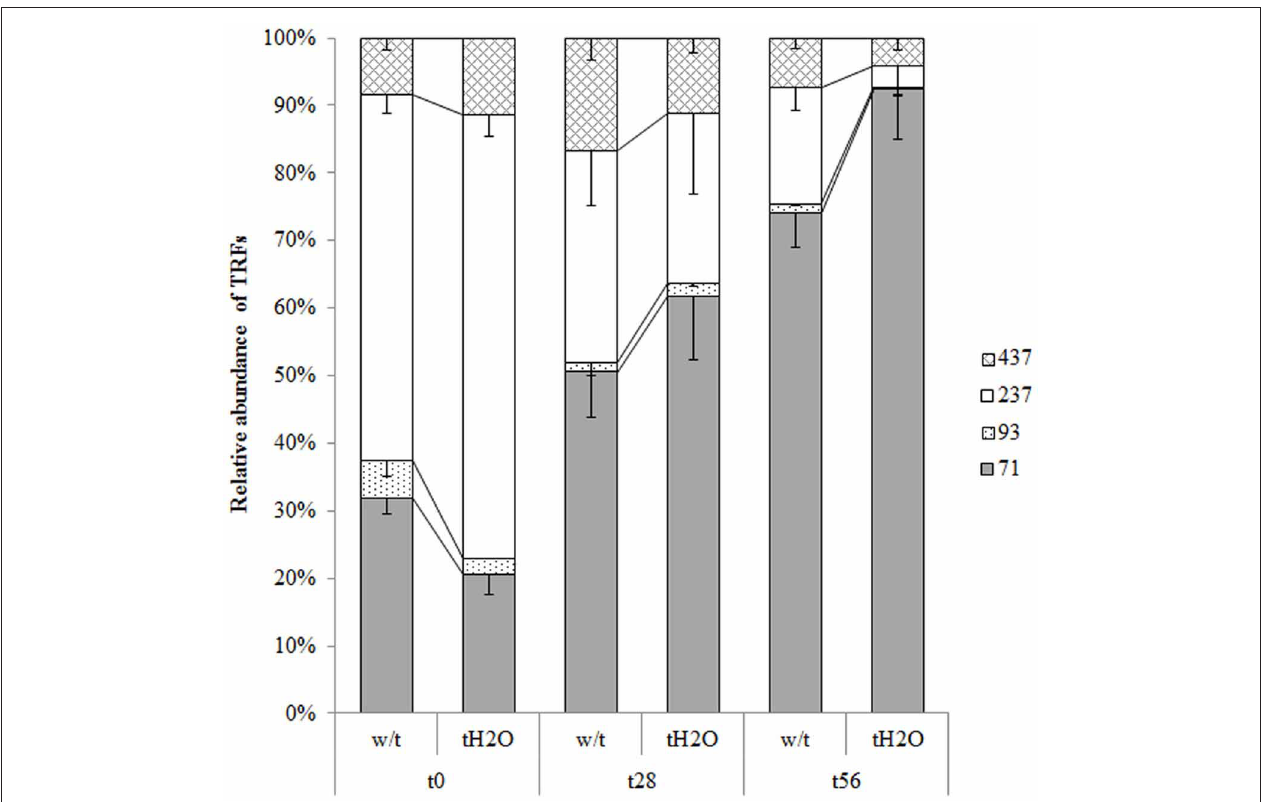
FIGURE 3 | Relativeabundances(meanvalues;errorbarsrepresent standarddeviation)oftheAOBbeta- amo genesT-RFsfrommicrocosms withouttreatment(w/t)andmicrocosmstreatedwithwatereach14